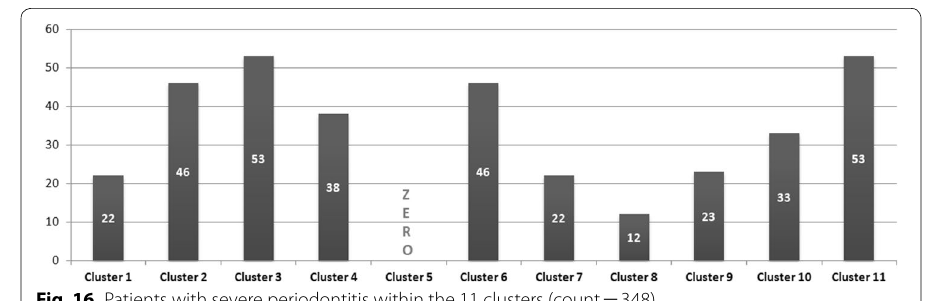
Fig. 16 Patients with severe periodontitis within the 11 clusters (count